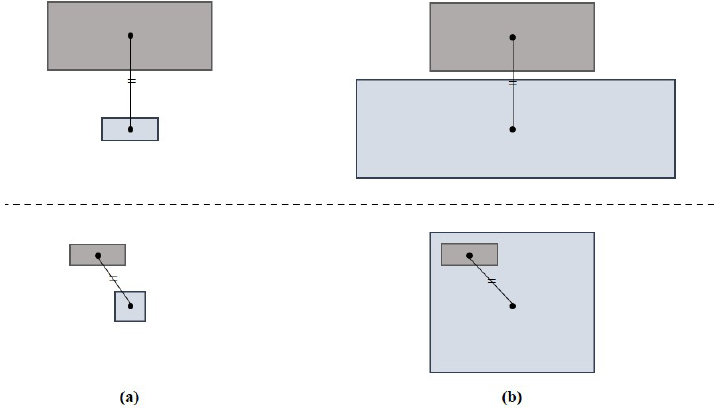
Figure 2. The Euclidean distances are the same in ( a , b ) for each case, but the actual distances seem remarkably different. The upper and lower case of ( b ) are likely to show an “on” and “attached” relation, respectively, which represents the definite nearness of the